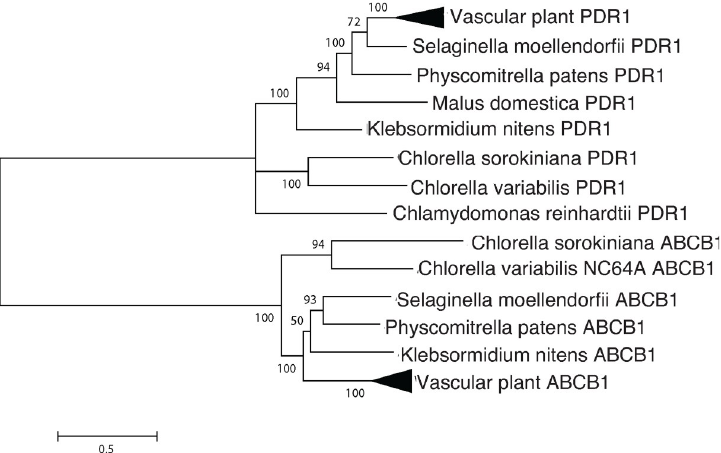
Fig 4. Phylogenetic analysis indicates sequence conservation of ABCB4. An ABCB transporter, is compared with a p- coumaric acid transporter which also transports a small organic molecule. Putative orthologs and outgroups were identified by reciprocal BLAST searches, aligned with Clustal Omega and analyzed using the LG+I substitution model in MEGA